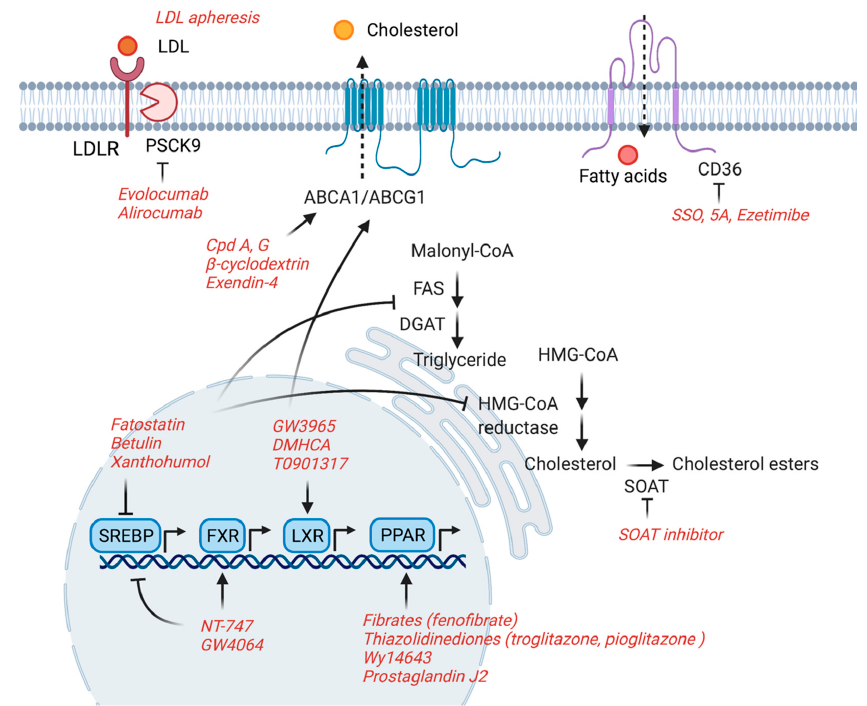
Figure 1. Potential therapeutic targets of lipid-modifying agents. ABCA1/ABCG1: ATP binding cassette subfamily A/G member 1; CD36: cluster of differentiation 36; DGAT: diacylglycerol O-acyltransferase; FAS: fatty acid synthase; FXR: farnesoid X receptor; HMGCR: 3-hydroxy-3-methyl-glutaryl-CoA reductase; LDL: low-density lipoprotein; LDLR: LDL receptor; LXR: liver X receptor; PCSK9: pro-protein convertase subtilisin/kexin type 9; PPAR: proliferator-activated receptor; SOAT: sterol O-acyltransferase; SREBP: sterol regulatory element-binding protein.